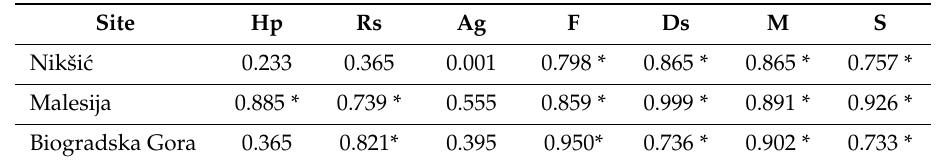
Table 6. Pearson correlation between the selected organs and sampling sites.